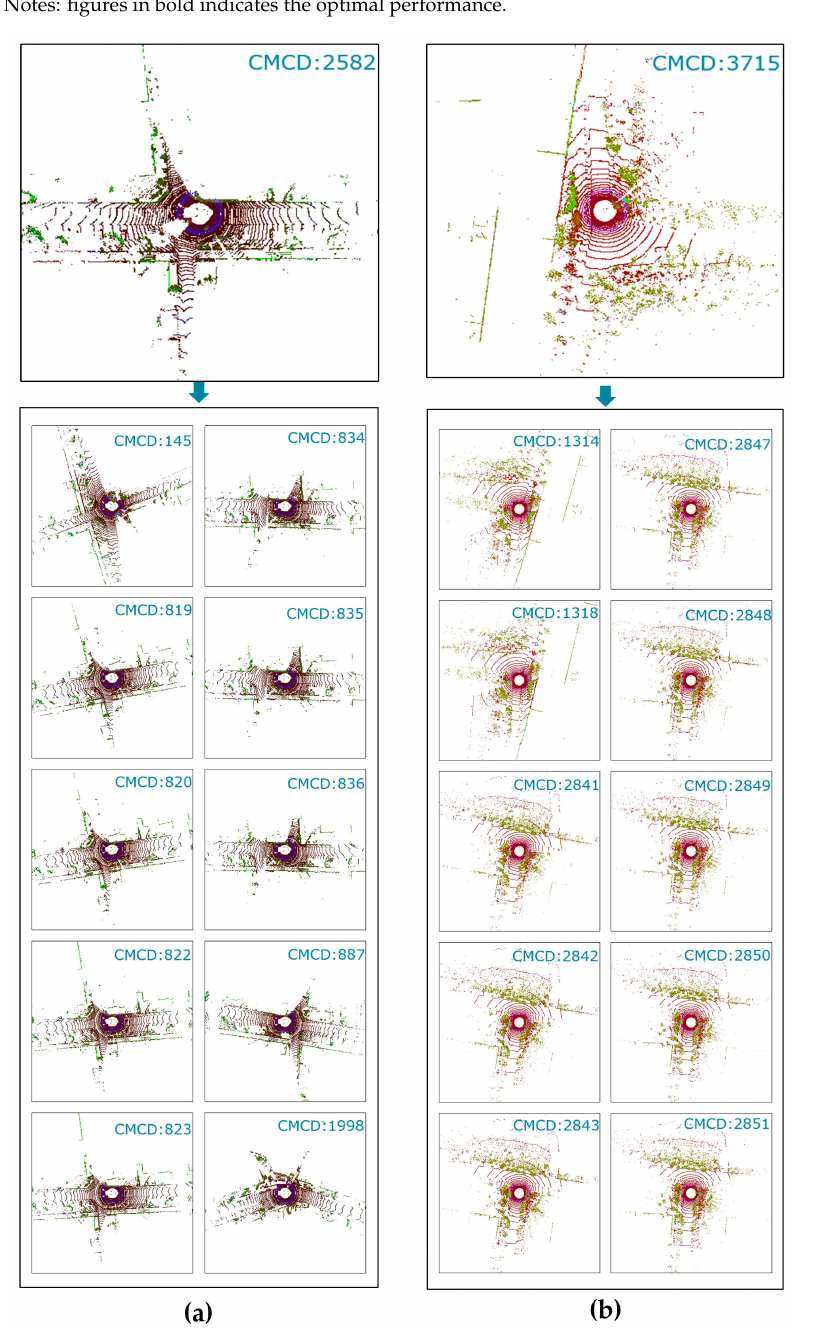
Figure 15. The retrieval results of the enhanced retrieval vector: ( a ) frame 2582 of KITTI-05 and its candidate set; ( b ) frame 3715 of jlu02 and its candidate set.